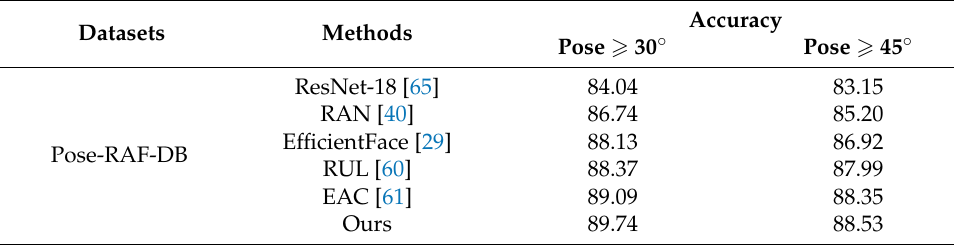
Table 6. Comparison with state-of-the-art methods on pose-RAF-DB.